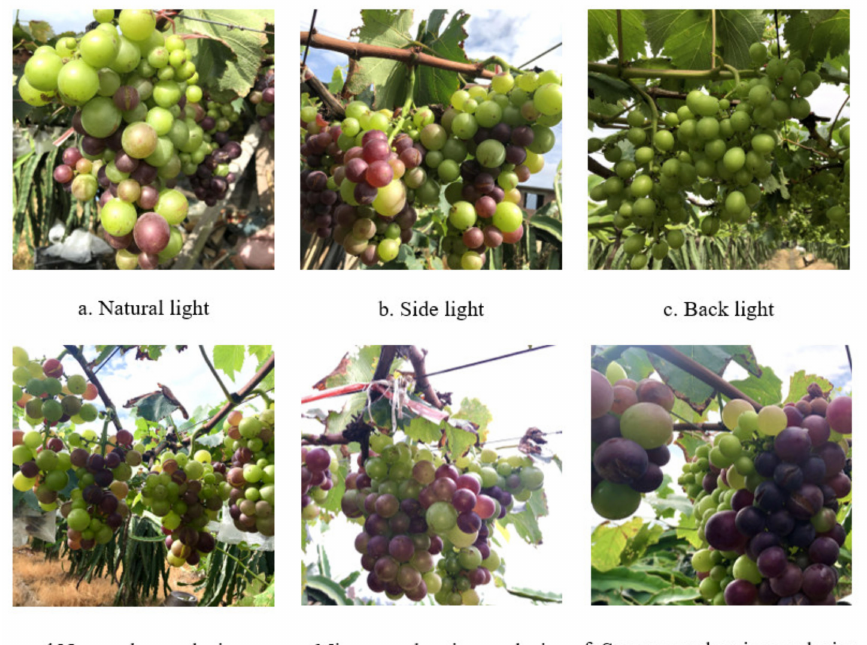
Figure 2. Grape images in complex